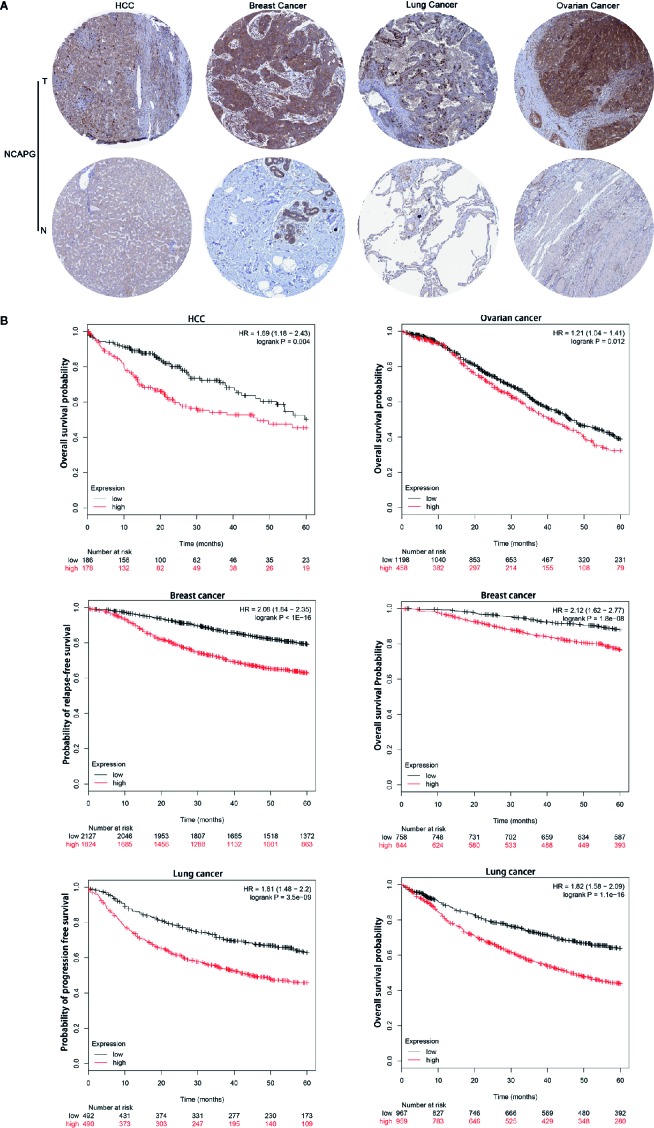
NCAPG correlated with poor survival in patients with tumors. (A) Immunohistochemistry data from The Human Protein Atlas (http://www.proteinatlas.org/). The results of immunohistochemistry from left to right were as follows HCC compared with normal liver tissue, breast cancer compared with normal breast tissue, lung cancer compared with normal lung tissue and ovarian cancer compared with normal ovarian tissue. NCAPG-positive cells displayed brown staining in the periphery and cytoplasm. (B) Determination of prognostic value of NCAPG mRNA expression via the Kaplan-Meier (KM) plotter. Survival curves are plotted for patients with HCC, breast cancer, lung cancer, and ovarian cancer. Red color represents tumor patients with high NCAPG expression and black color represents tumor patients with low NCAPG expression.